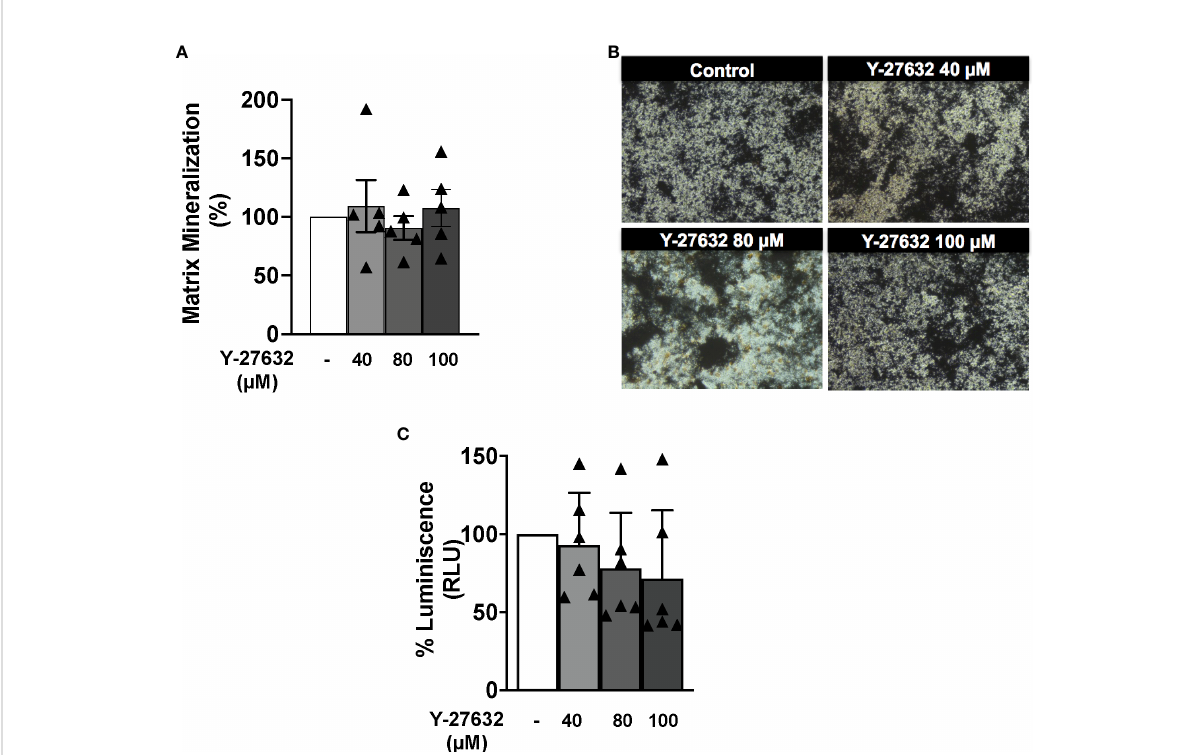
FIGURE 6 The ROCK inhibitor Y-27632 did not modulate osteoblast activity. (A) Percentage of matrix mineralization produced by in vitro differentiated osteoblasts from arthritic mice, treated with different concentrations of Y-27632. Control without treatment was considered 100%. (B) Representative imagens are shown. (C) Cell viability in the differentiation of osteoblasts treated for 10 days with the indicated Y-27632 concentrations. Viability was determined using the Cell Titer-Glo luminescent assay kit and expressed relative to the cultures without Y-27632 (100%). Values are the mean ± SEM of cells from 5 arthritic mice in (A) and 6 in (C)